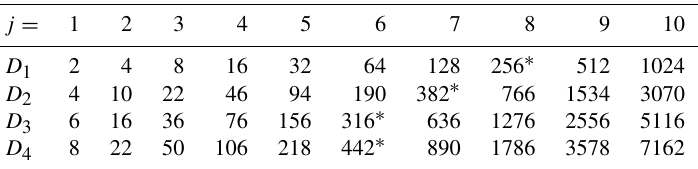
Figure 3. Vertical (a) , horizontal (b) and diagonal (c) daughter wavelet for D 2 . Table 1. Side length of the daughter wavelets’ support as a function of the scale j for the first 10 Daubechies wavelets. For each mother wavelet, the star marks the largest daughter wavelet with support size smaller than 2 9